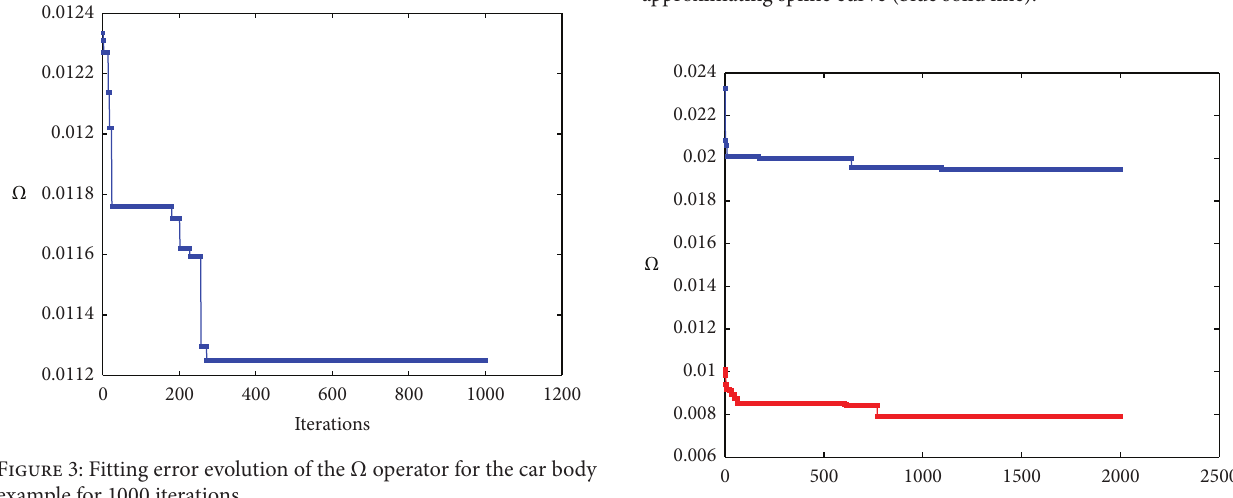
Figure 4: Adjusting data points (red cross symbols in both pictures) of two outlines curves of a paint spray gun with our method: (left) reconstructed data points (blue empty circle symbols); (right) approximating spline curve (blue solid line).